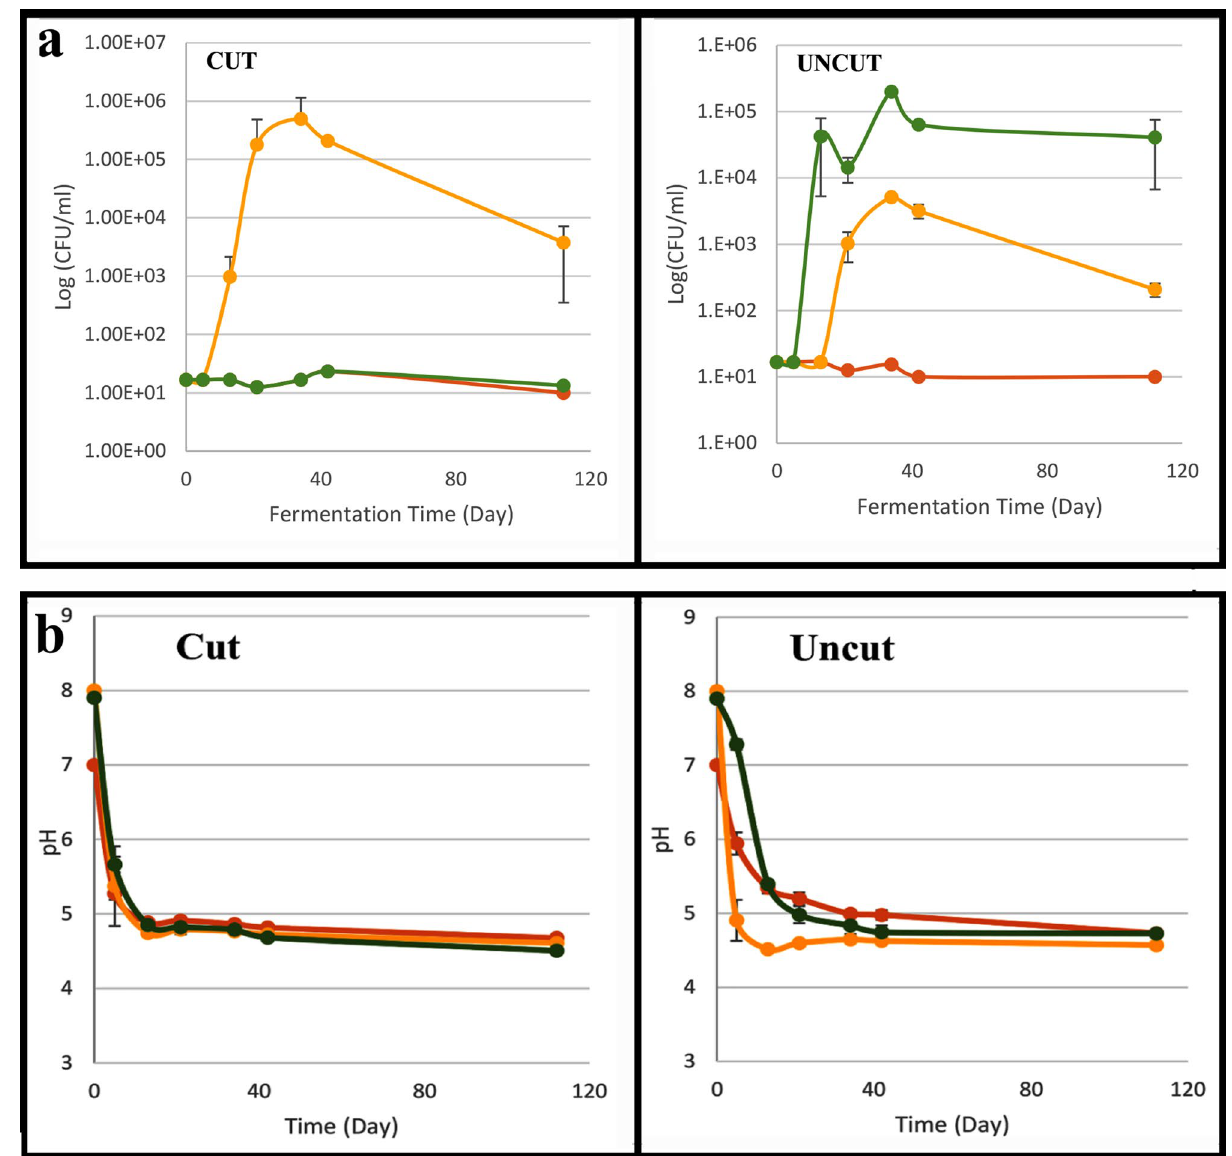
Figure 8. Results of experiments on different fermentation conditions. Red—Tap water + 11% NaCl; Orange— Seawater; Green—Seawater + 8% sea salt. Each point in the graphs indicates the average of three independent repetitions (N = 3). The error bars indicate the standard deviation (SD). When SD is smaller than the symbol, it is not visible in the graph: ( a ) Growth curve of total aerobic bacteria presented as log (CFU/ml) versus fermentation time. ( b ) Changes in pH values during 112 days of fermentation. As expected, the pH values decreased during fermentation. The accelerated decline was observed in fermentation with seawater brine and uncut olives. ( c ) The alteration in Young’s Modulus and Stiffness values during 60 days of